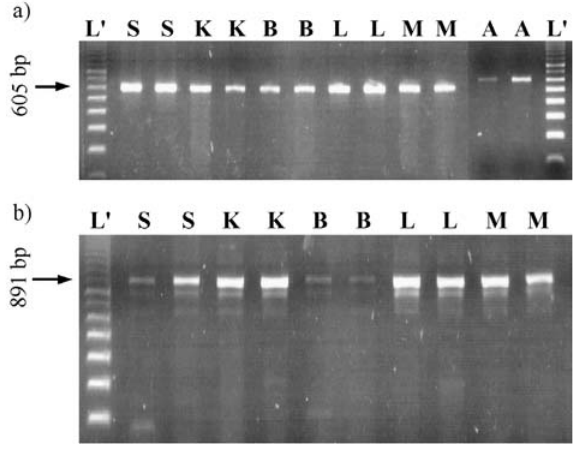
Figure 2 - a: 605bp fragment amplified by PCR visualized in 1.5% agarose gel under UV light. (L’) 100bp DNA Ladder, (S) Skin, (K) Kid- ney, (B) Brain, (L) Liver, (M) Muscle and (A) Adipose tissues. b: 891bp fragment amplified by PCR visualized in 1.5% agarose gel under UV light. (L’) 100pb DNA Ladder, (S) Skin, (K) Kidney, (B) Brain, (L) Liver, (M) Muscle and (A) Adipose tissues.